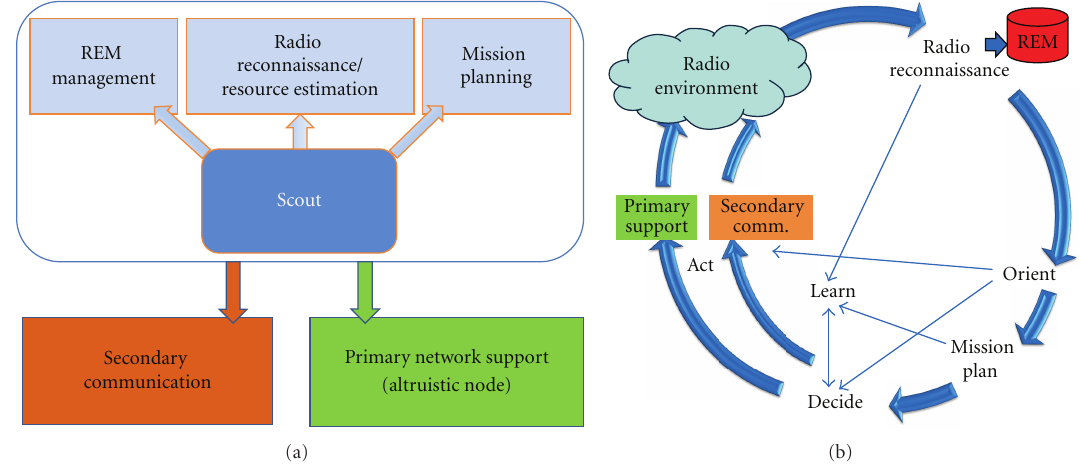
Figure 2: (a) A functional architecture of the scout and (b) a simple scout cycle of operation.